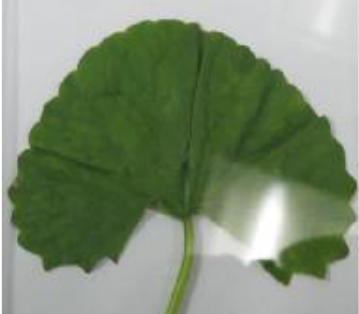
Figure 1. Centella Asiatica Fresh Leave Extraction Method